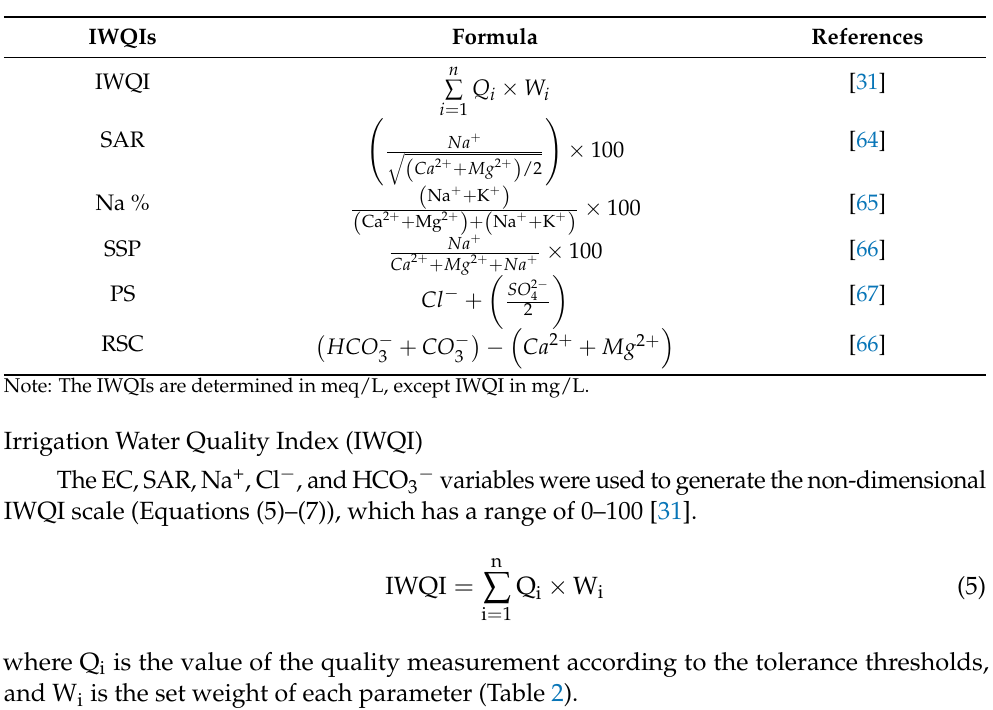
Table 1. The calculation methods of the irrigation indices.